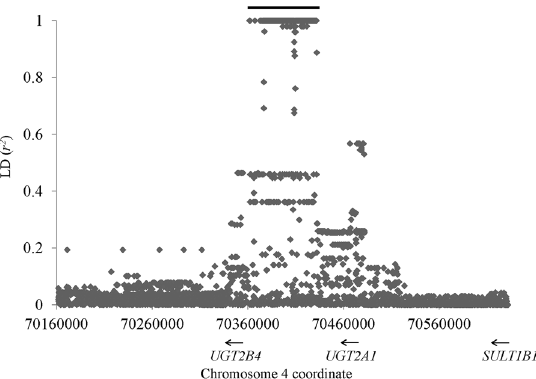
Figure 1. LD pattern in UGT2B4 region. The x axis indicates chr4 coordinate while y axis denotes the r 2 value with the tag SNP rs11723463. Each diamond represents one genetic variation. The bar in top points out the position of the long LD region. The horizontal arrows in bottom denote the schematic location and transcript orientation of the genes in this